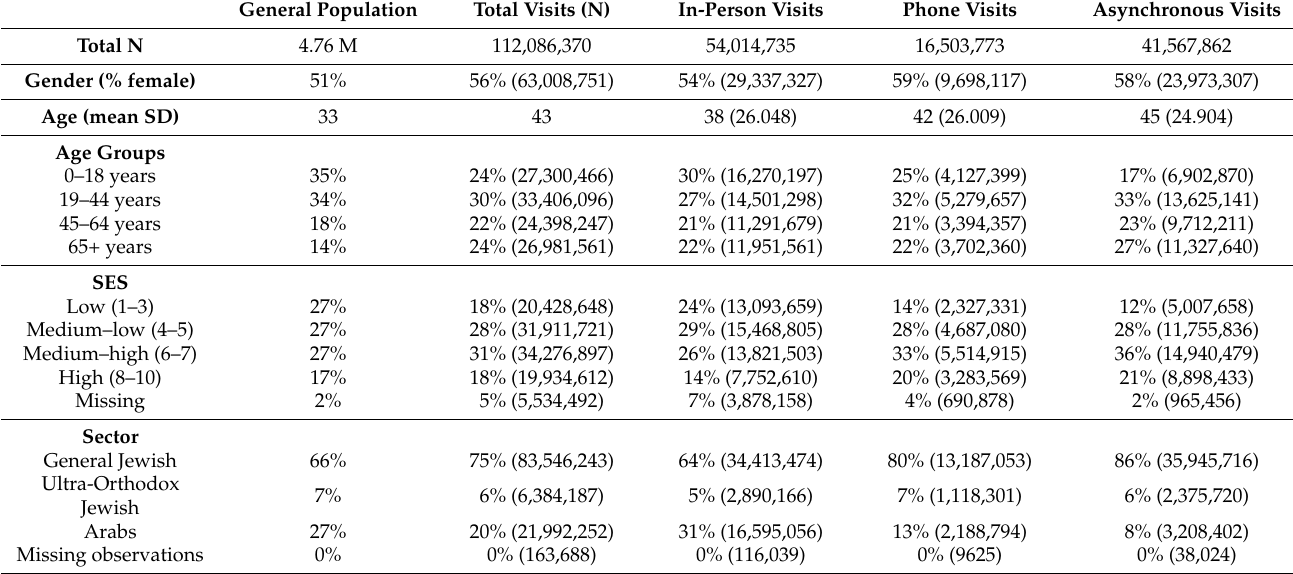
Table 1. Demographics characteristics.